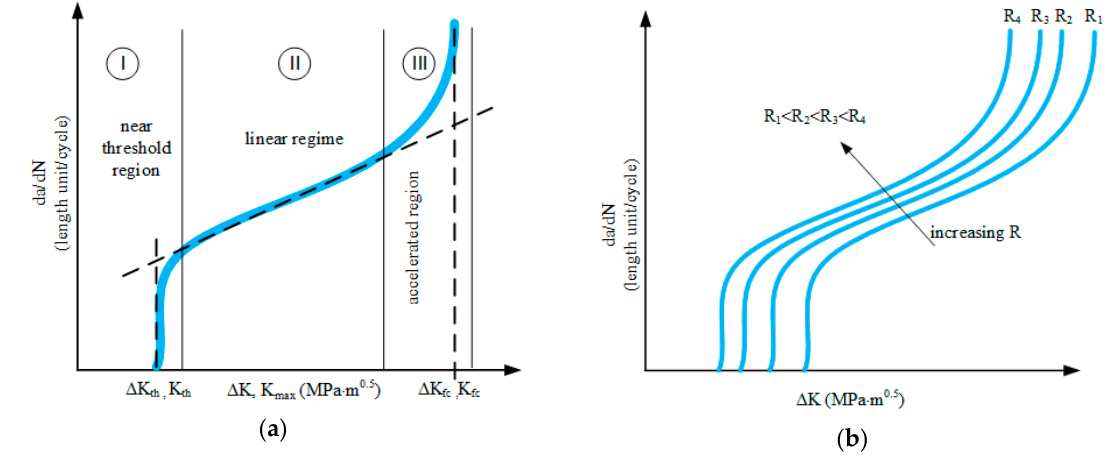
Figure 1. Schematic Kinetic Fatigue Fracture Diagram (KFFD): ( a ) sigmoidal shape of the fatigue crack growth rate (FCGR) curve; ( b ) the scheme of the stress R-ratio impact on the FCGR curves (R 4 > R 3 > R 2 > R 1 ).